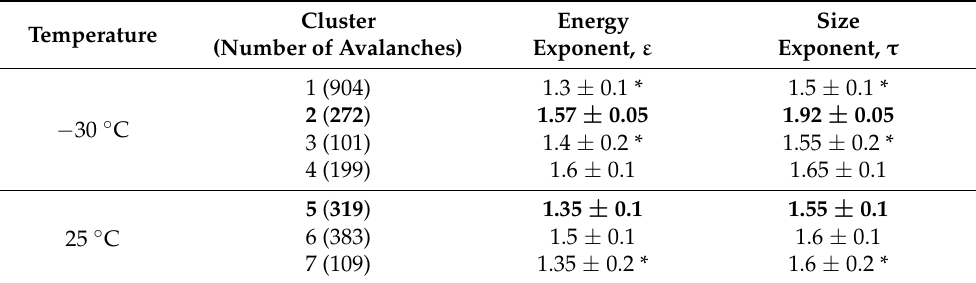
Table 1. Energy and size exponent values for all clusters, determined with maximum-likelihood estimation. The values for Clusters 2 and 5, corresponding to twinning and dislocation slip are highlighted in bold, while the asterisk draws attention to the high uncertainty, caused by the ex- tremely low number of avalanches ( ≈ 100) and/or by the relatively high number of small avalanches (Cluster 1). Clusters 4 and 6 are attributed to background vibrations (see also the